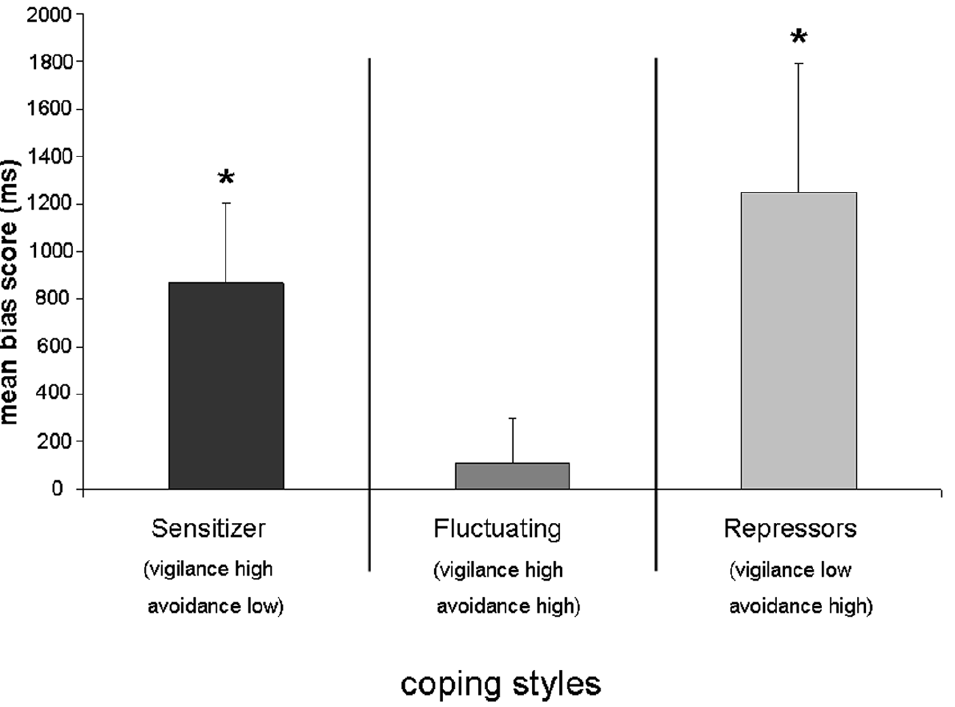
Figure 2. Mean bias scores (gaze duration viewing positive faces – gaze duration viewing threatening faces) of sensitizers, fluctuating subjects, and repressors (and standard errors of the mean) during the interval 500–8000 ms. The asterisks indicate that the bias scores significant differ from zero. **: p , .01. *: p , .05.